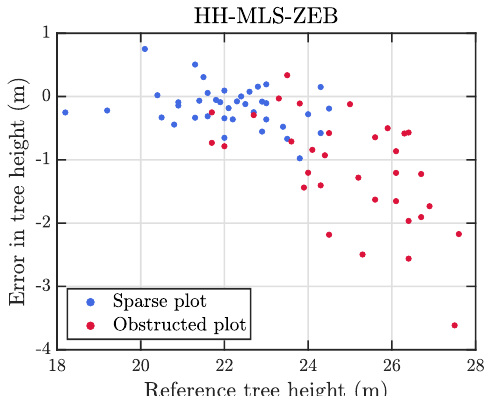
Figure 12. Error in the tree heights estimated from the point cloud collected with the handheld Zeb-Horizon scanner as a function of tree height. Note the increasing underestimation in the heights of trees taller than 25